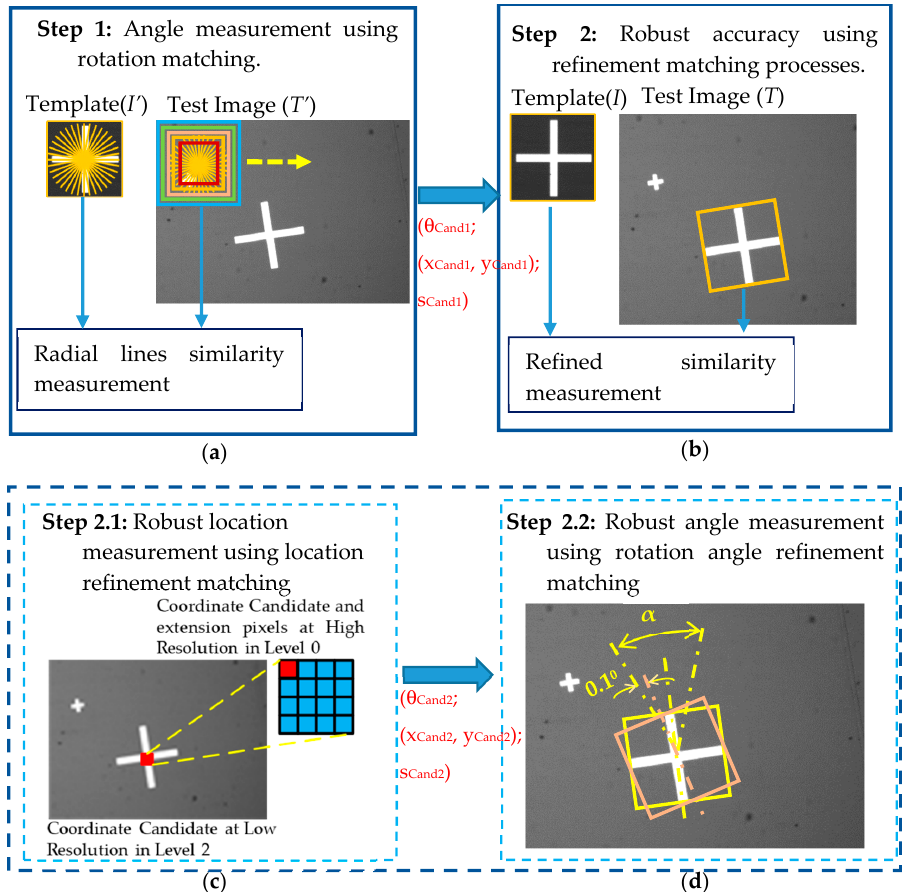
Figure 4. Global framework of the RST refinement template matching algorithm. ( a ) Angle matching process based on the radial line features, with outputs of the angle candidate ( θ Cand1 ), the scale candidate ( s Cand1 ) and the coordinate candidate ( x Cand1 , y Cand1 ); ( b ) refinement matching process comprising two sub-steps for the position matching and the angle matching, respectively; ( c )